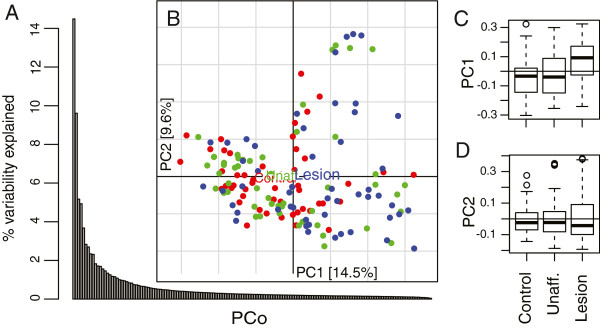
Principal coordinates analysis (PCoA) of weighted Unifrac distances. Based on separation of the relative values of the percentage variability explained by the principal axes, we chose to represent the cutaneous microbiome of our study in the first two components (A). (B) On the scatterplot of the first two principal axes of the PCoA, each point represents an individual subject (red = control, green = unaffected, blue = lesion) and the colored boxes are positioned at the geometrical center of all the points in the corresponding groups. The distributions of the points along PC1 (C) and PC2 (D) are shown in the boxes (representing the middle 50% of the data) and whiskers (95% interval) plots. Along PC1, lesion samples are significantly different from control (P <0.001) and unaffected (P <0.015) based on one-way analysis of variance (ANOVA) with Tukey honestly significant difference (HSD) multiple comparison correction.